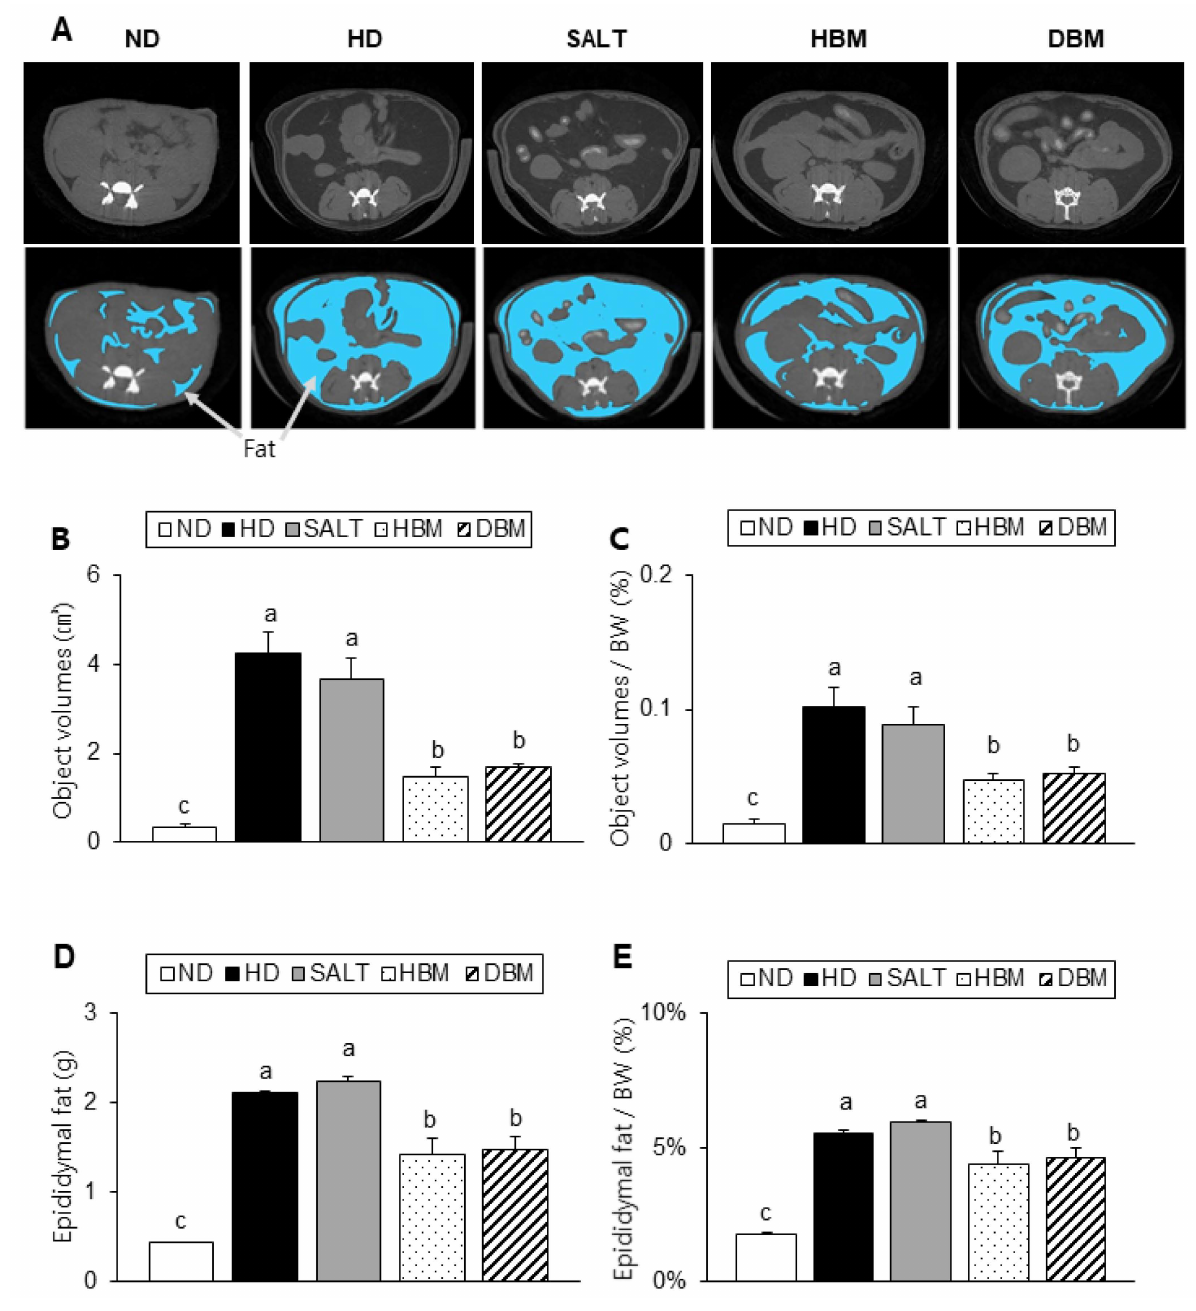
Figure 3. Effects of Gochujang on dyslipidemia in the HD-fed mice. ( A ) Micro-CT image of abdominal area (dark gray portions indicate fat tissue, which illustrated under picture with blue portions, white portions indicate bone, and light gray portions indicate organs); ( B ) Fat tissue volumes at the micro- CT; ( C ) Fat volume at the micro-CT per body weight (BW); ( D ) Epididymal fat; ( E ) Epididymal fat per BW. Values are mean ± SEM. a–c means with the different letters on the bar ( p < 0.05). (a > b > c). ND, normal diet group; HD, high-fat diet group; SALT, HD with 0.7% salt group; HBM, HD with 10% of HBM Gochujang group; DBM, HD with 10% of DBM Gochujang